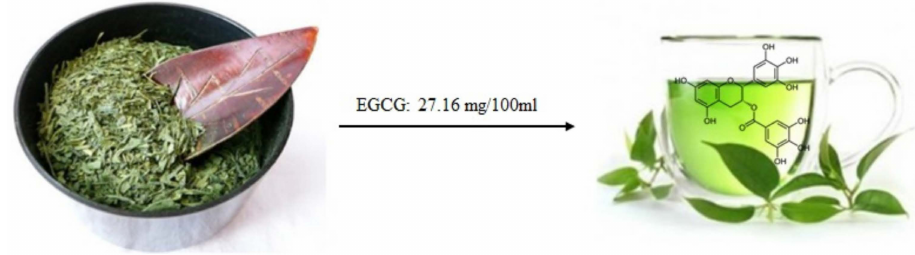
Figure 4. Epigallocatechin-3-gallate (EGCG) from green tea, according to the database Phenol-Explore (http: // phenol-explorer.eu / ).